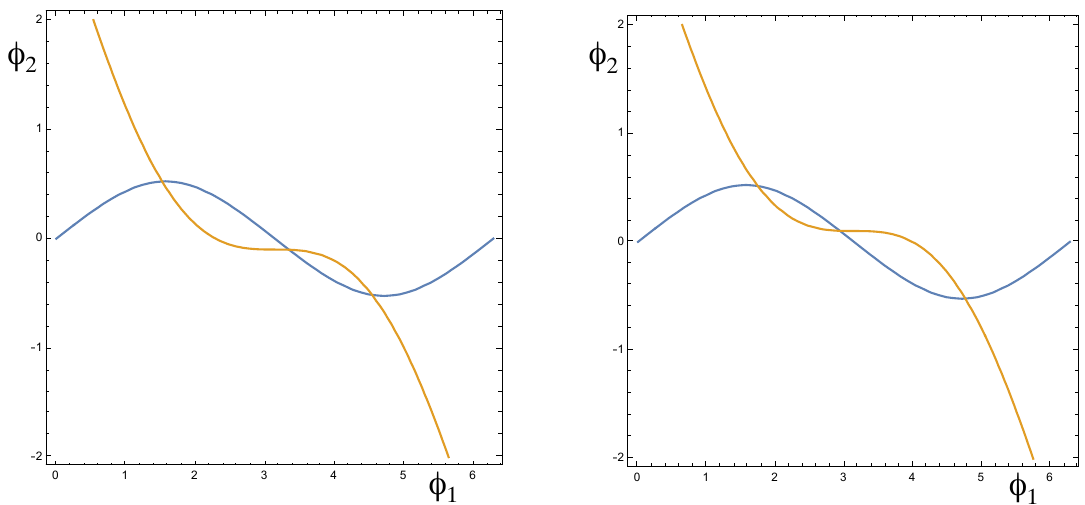
Figure 5 . Same as (cid:12)gure 4 in the CP broken situation, but for two values of (cid:18) on opposite sides